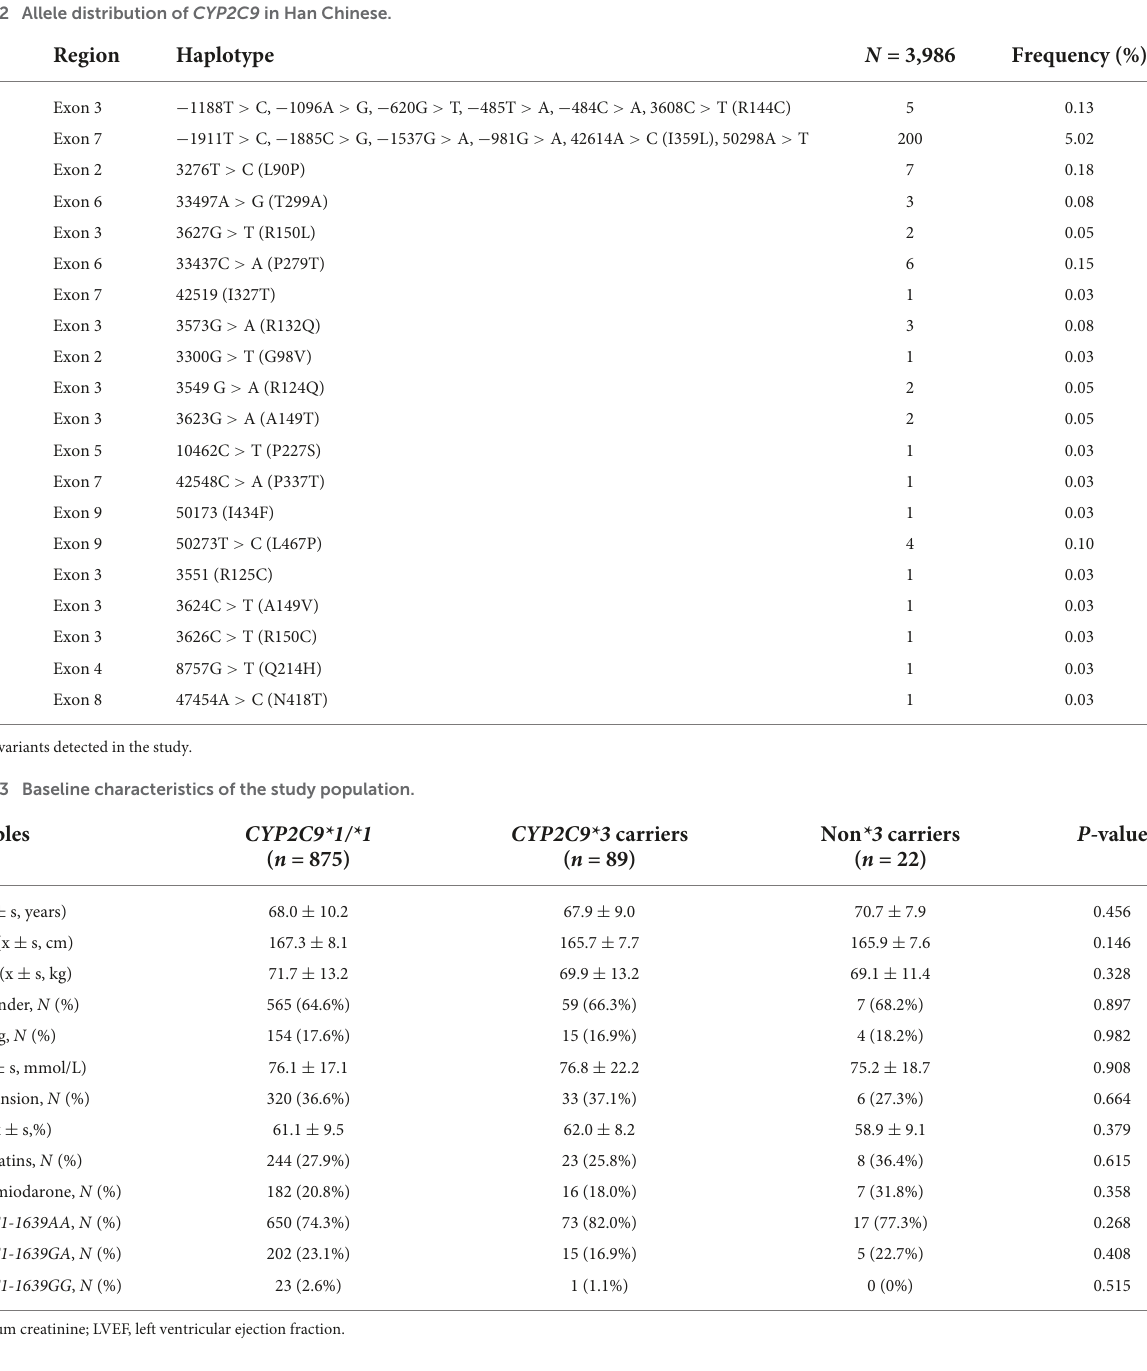
TABLE 2 Allele distribution of CYP2C9 in Han Chinese.